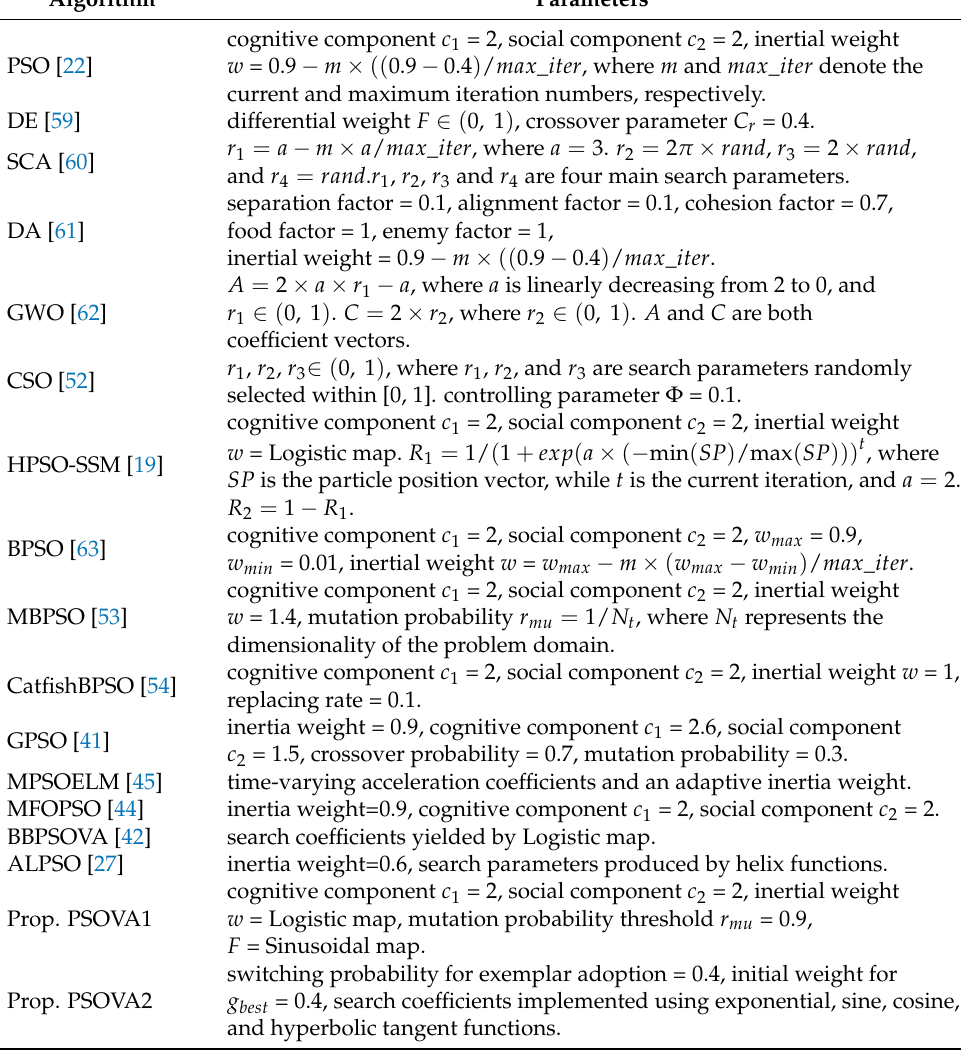
Table 3. Parameter settings of each